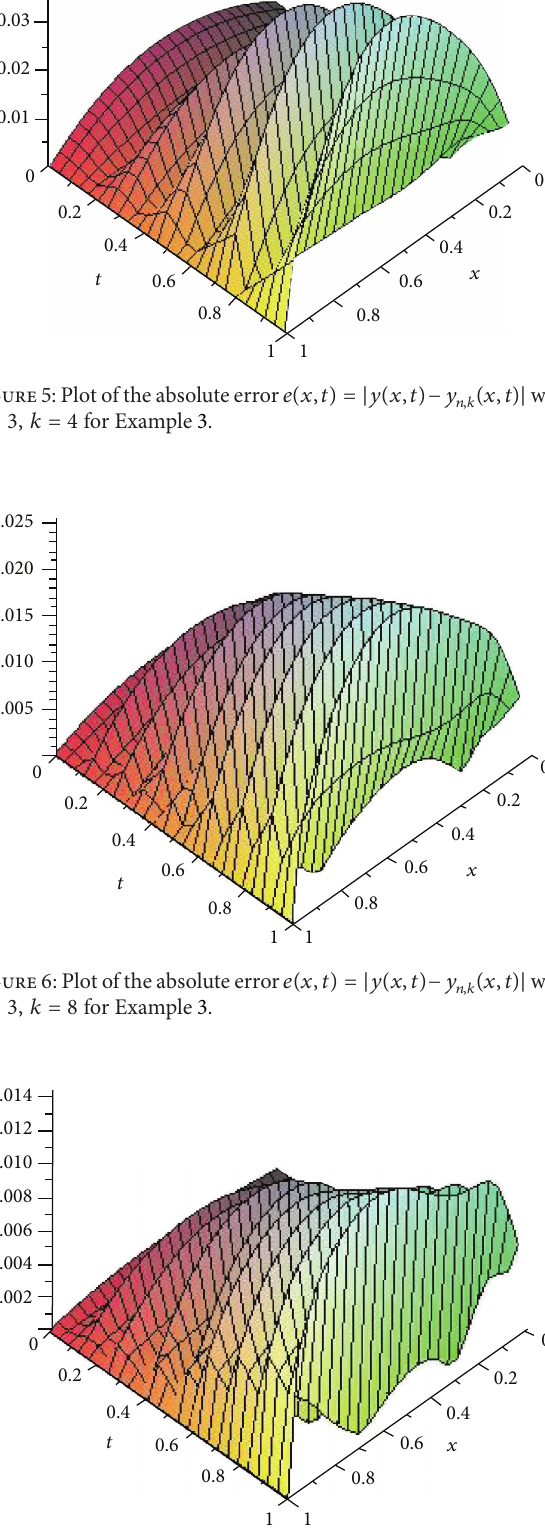
Figure 7: Plot of the absolute error 𝑒(𝑥, 𝑡) = |𝑦(𝑥,𝑡)−𝑦 𝑛,𝑘 (𝑥,𝑡)| with 𝑛 = 3, 𝑘 = 16 for Example